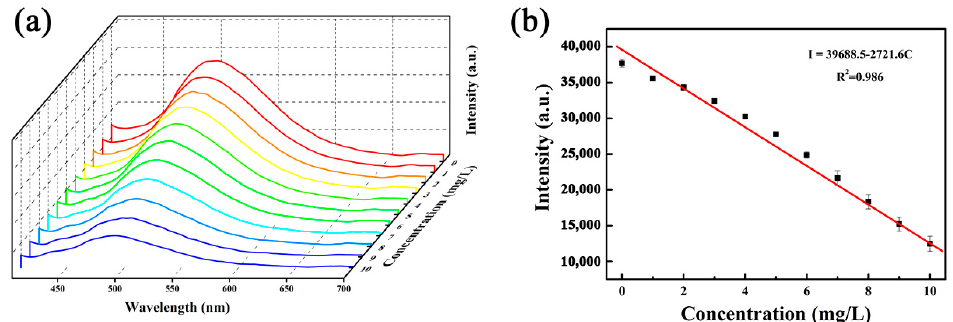
Figure 6. Emission spectra ( a ) and concentration dependence of the fluorescent intensity ( b ) of Ag + @UiO-66-(COOH) 2 upon the addition of different concentrations of I − .